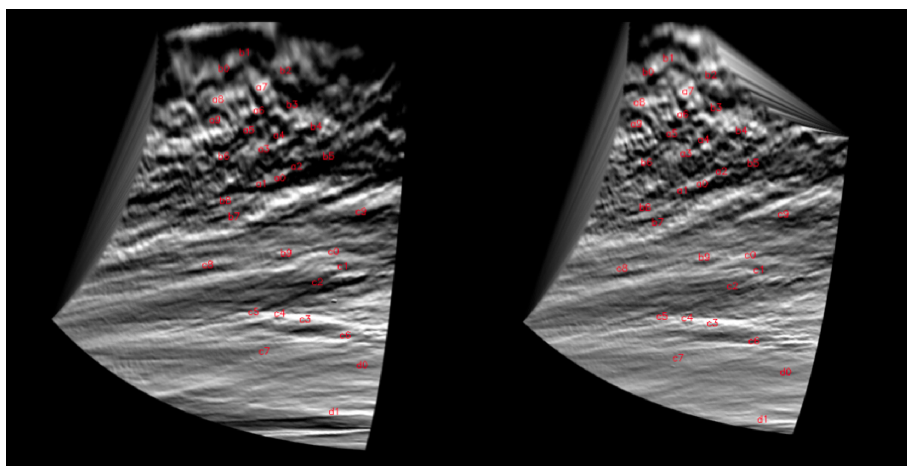
Figure 5. Example of a pair of Venus’ dayside VIRTIS-M/VEx images coordinated with the TNG/NICS observations. The tracers of correspondent cloud features in both images are marked in red. The time gap between the exposure related to image A and B was of one hour. In these images we can see the morphology of the upper cloud deck observed by Venus Express/VIRTIS-M images at 380 nm on the 11 July 2012. Apparent motions of UV upper cloud features were manually tracked on projected and processed VIRTIS’ cubes images [39] of the same area. The figure shows VIRTIS-M UV-visible channel images from orbit 2273 and after image processing and equirectangular